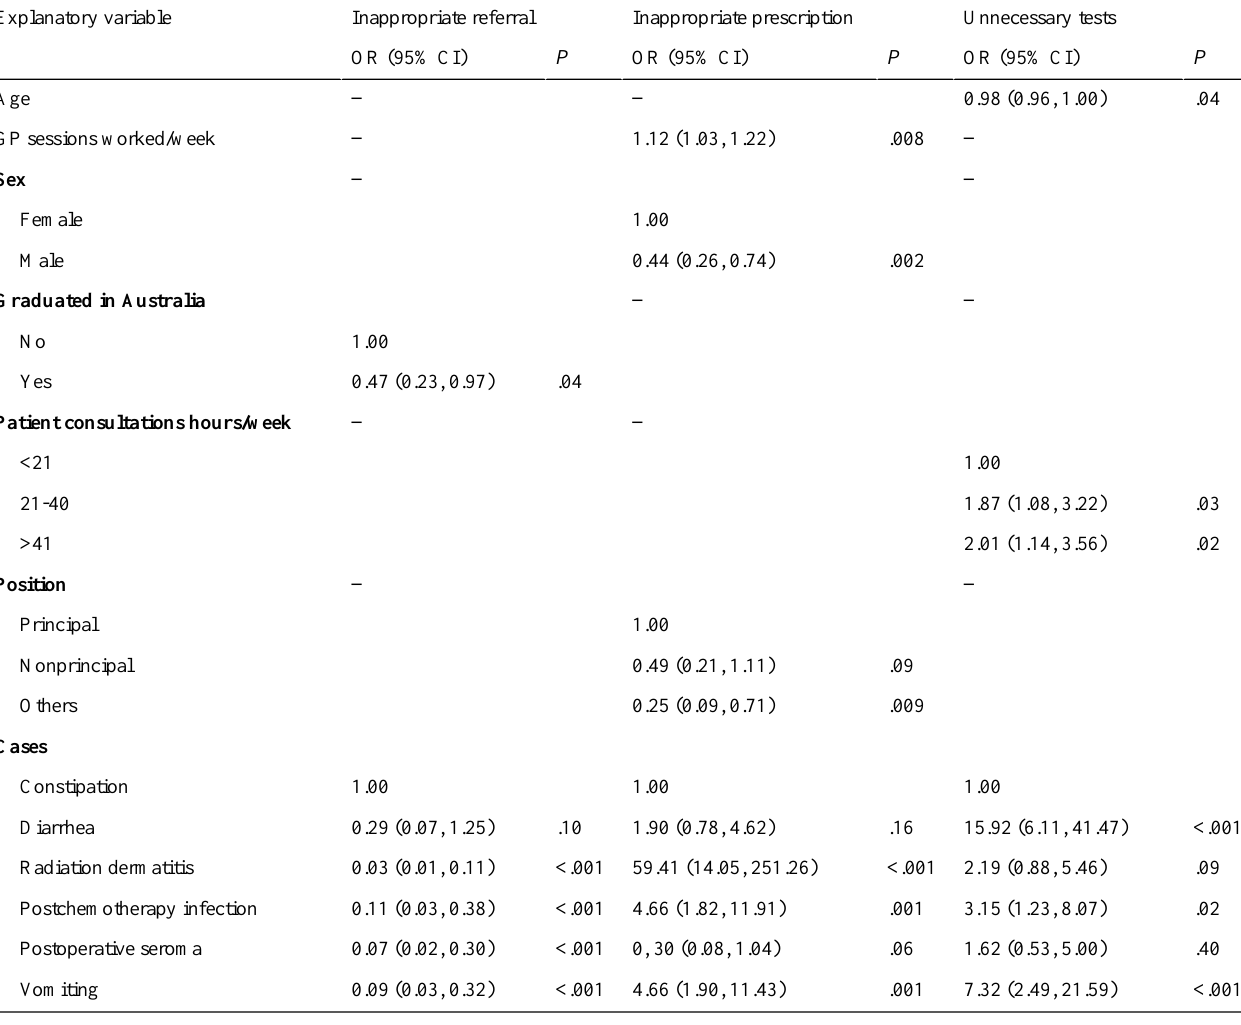
Table 5. Factors associated with incorrect management (inconsistent with expert opinion) in phase 1 (N=50).